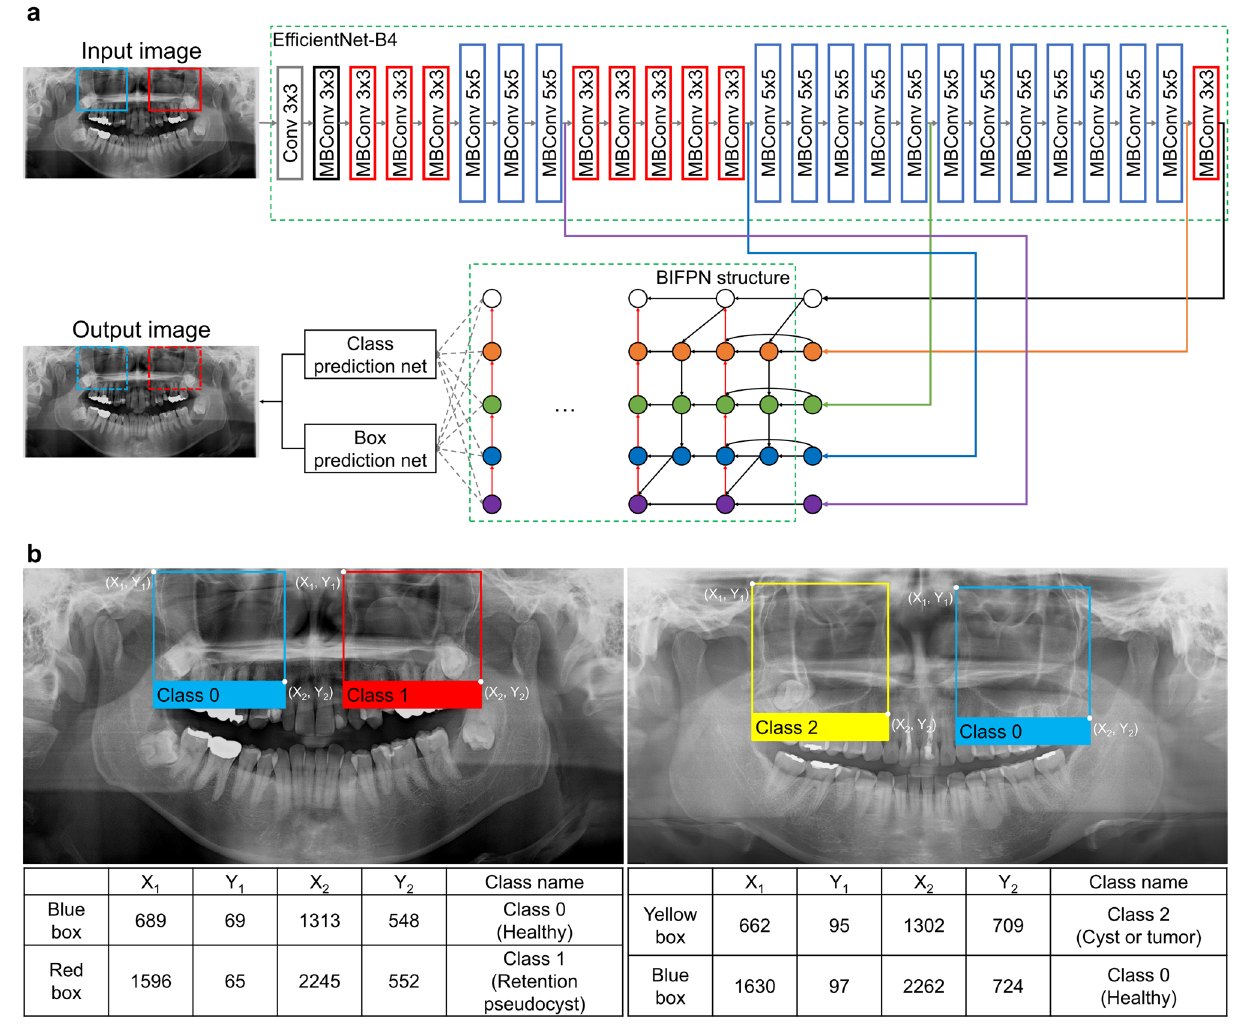
Figure 1. Model architecture and annotation. Overall architecture of the proposed model from EfficientDet-D4 ( a ). Conv, convolutional network; MBConv, mobile inverted bottleneck convolution block; BIFPN, bi-feature pyramid network. Examples of annotated panoramic radiographs and annotation information ( b ). The blue boxes indicate class 0 (healthy), the red box indicates class 1 (retention pseudocyst), and the yellow box indicates class 2 (cyst or tumor). The information was composed of the location, represented as the upper left (X 1 , Y 1 ) and the lower right (X 2 , Y 2 ), and each class